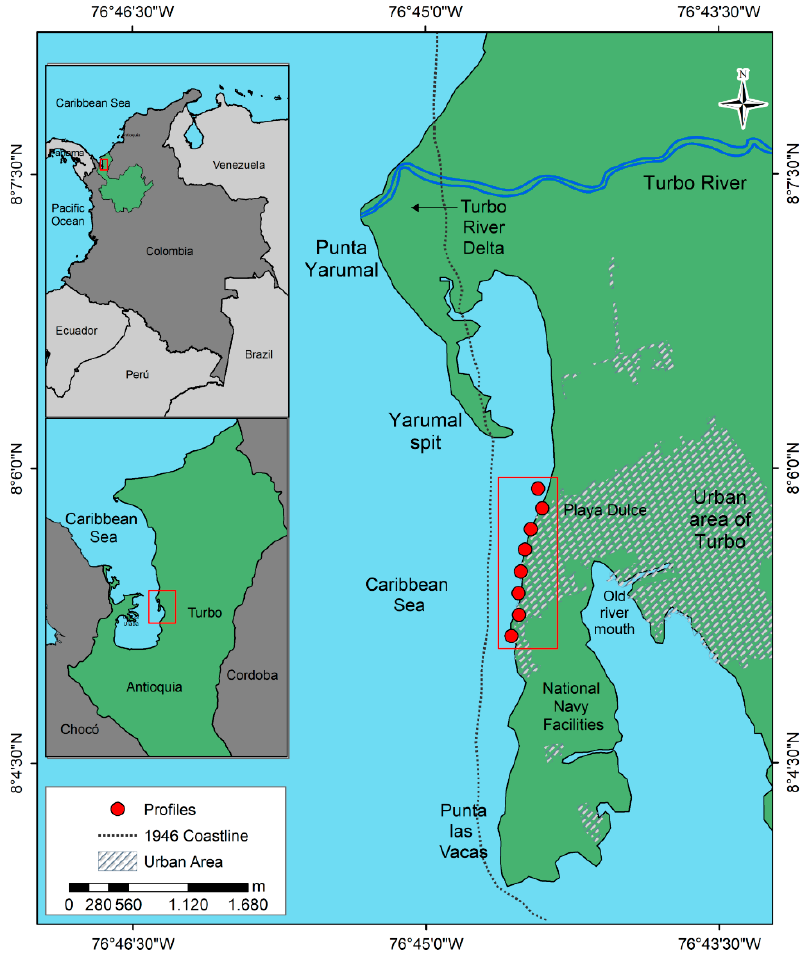
Figure 1. Location of Antioquia, Colombian Caribbean.